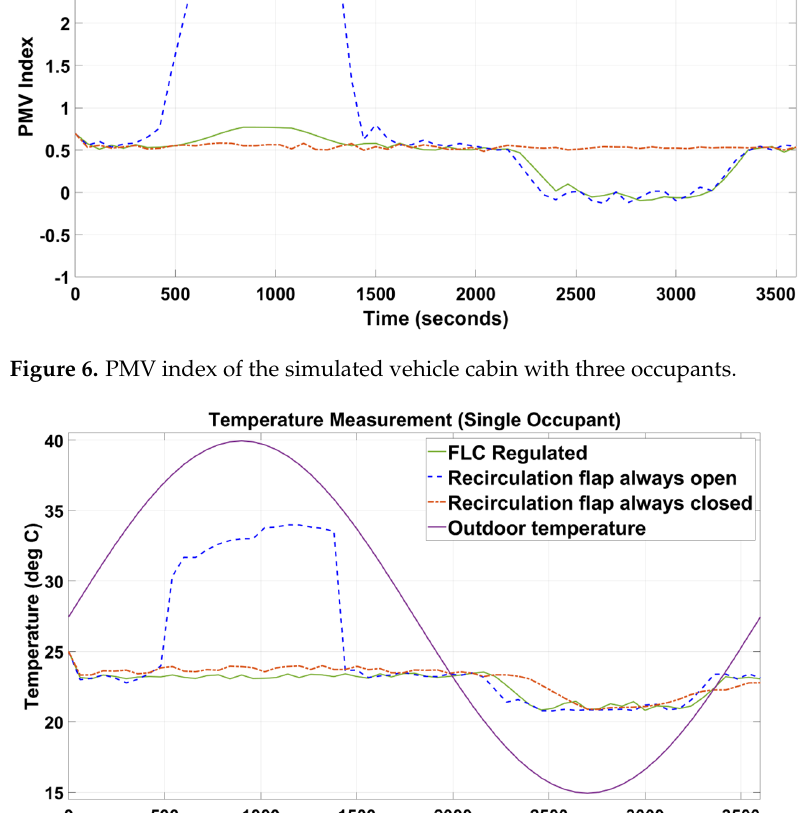
Figure 7. Indoor temperature of the simulated vehicle cabin with one occupant and outdoor temperature.